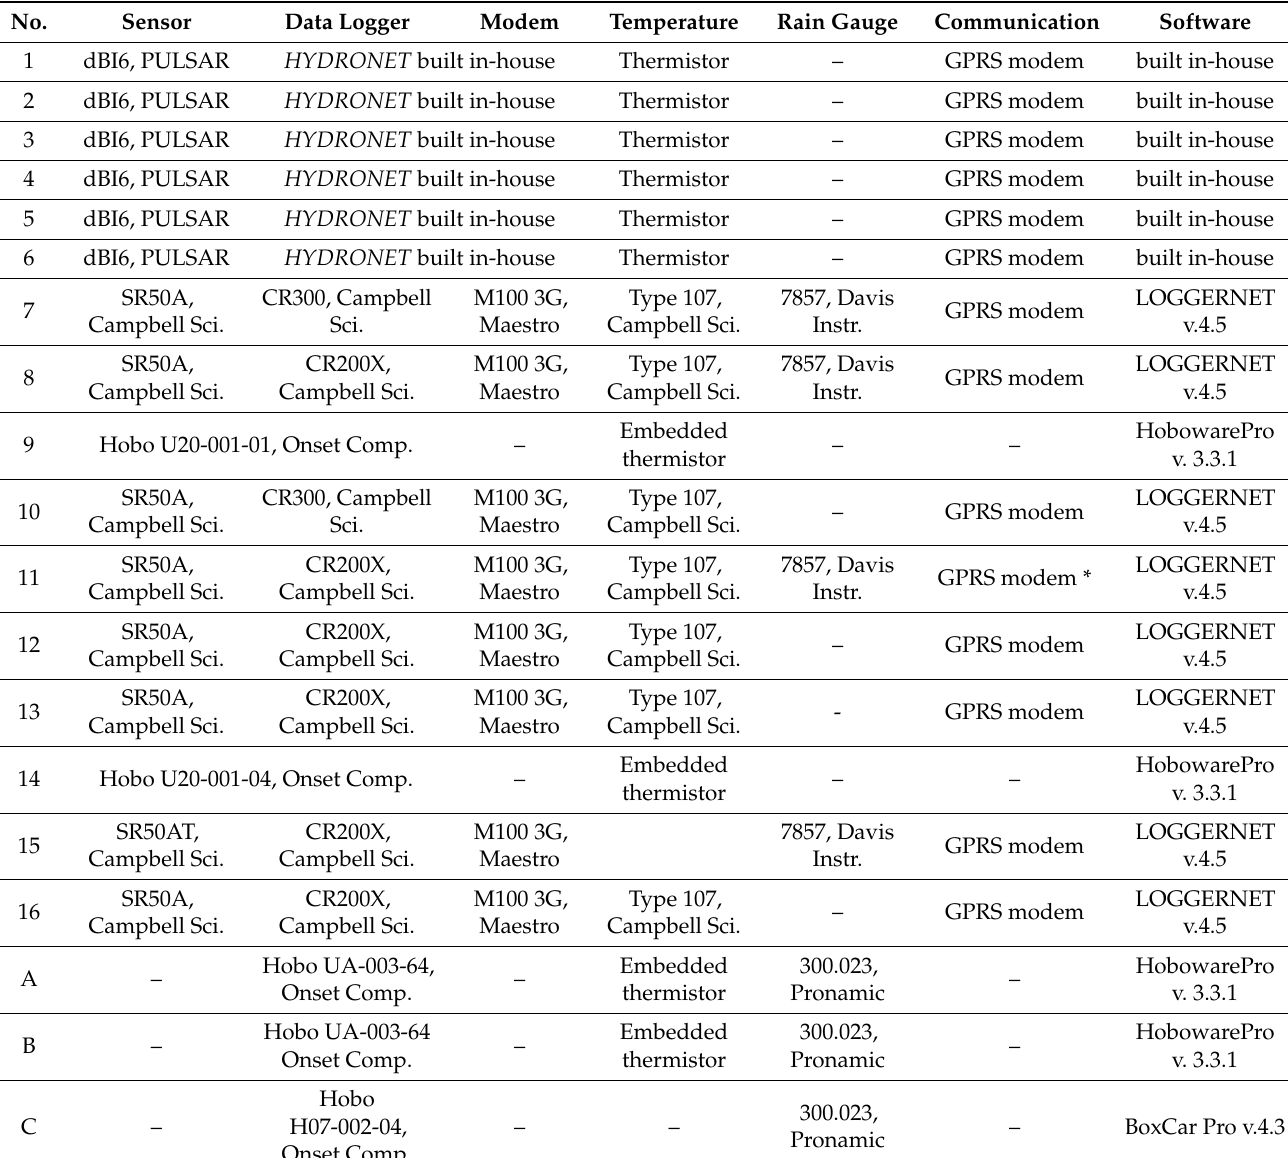
Table 2. Stations with types of equipment and